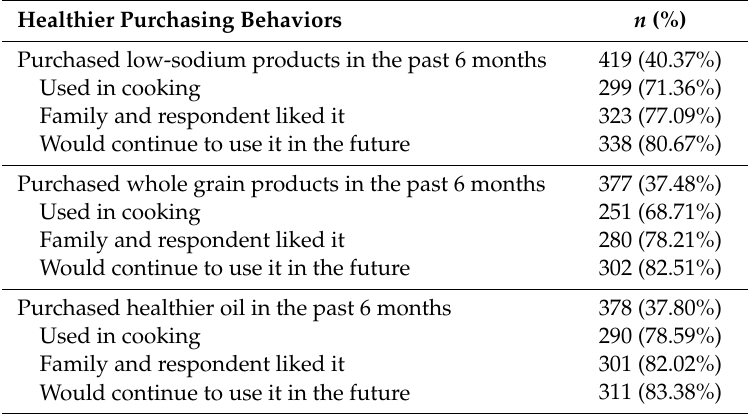
Table 5. Outcome Measures: Healthier Purchasing Behaviors at 12-Month Follow-Up